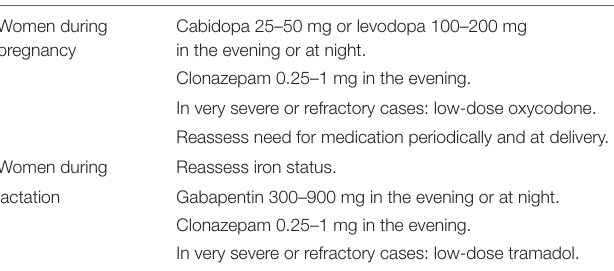
TABLE 5 | Medication treatment for RLS in women during pregnancy and lactation. Women during